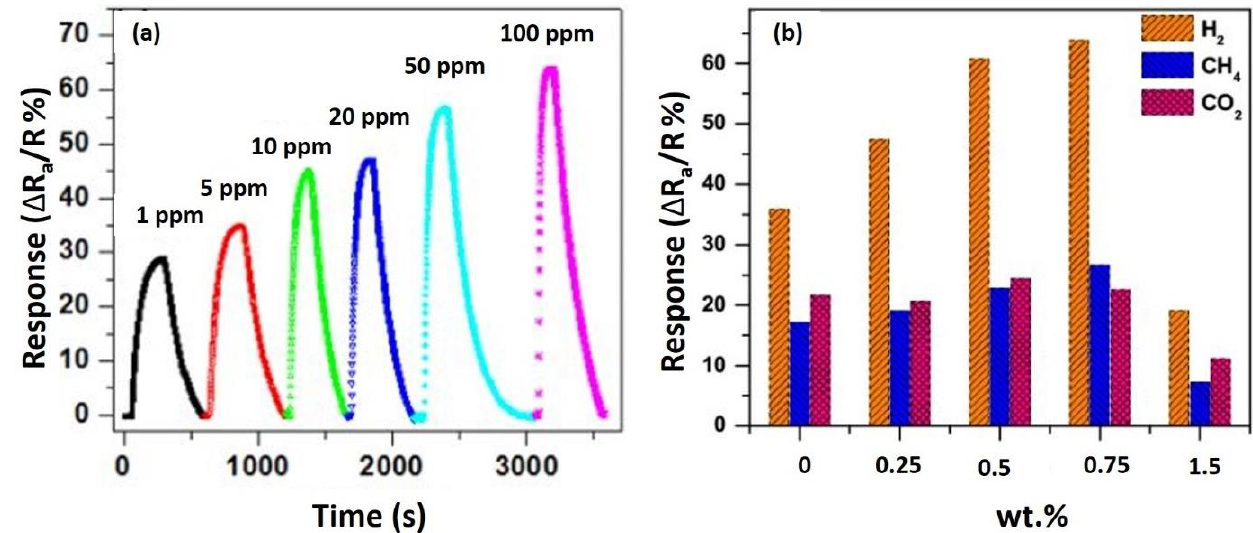
Figure 12. ( a ) Response of rGO-Ni-doped ZnO nanostructures toward H 2 concentration of 1 – 100 ppm at 150 °C for 0.75 wt.% rGO loading and ( b ) the selectivity response for pristine rGO and various rGO loaded-Ni-doped ZnO nanostructure-based sensors. Reproduced from ref. [171].